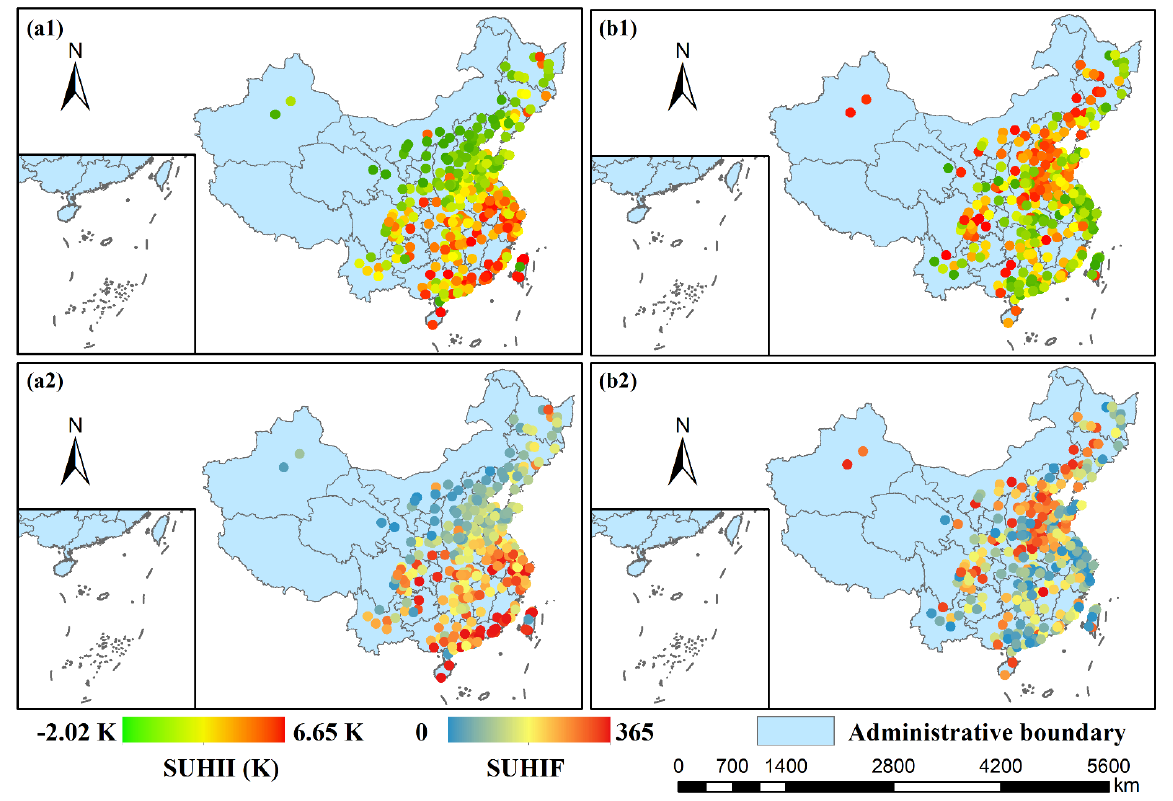
Figure 3. Spatial distribution of SUHII and SUHIF at daytime ( a ) and nighttime ( b ) in China. The spatial maps in the first row represent SUHII ( a1 , b1 ). The second row maps represent SUHIF ( a2 , b2 ).